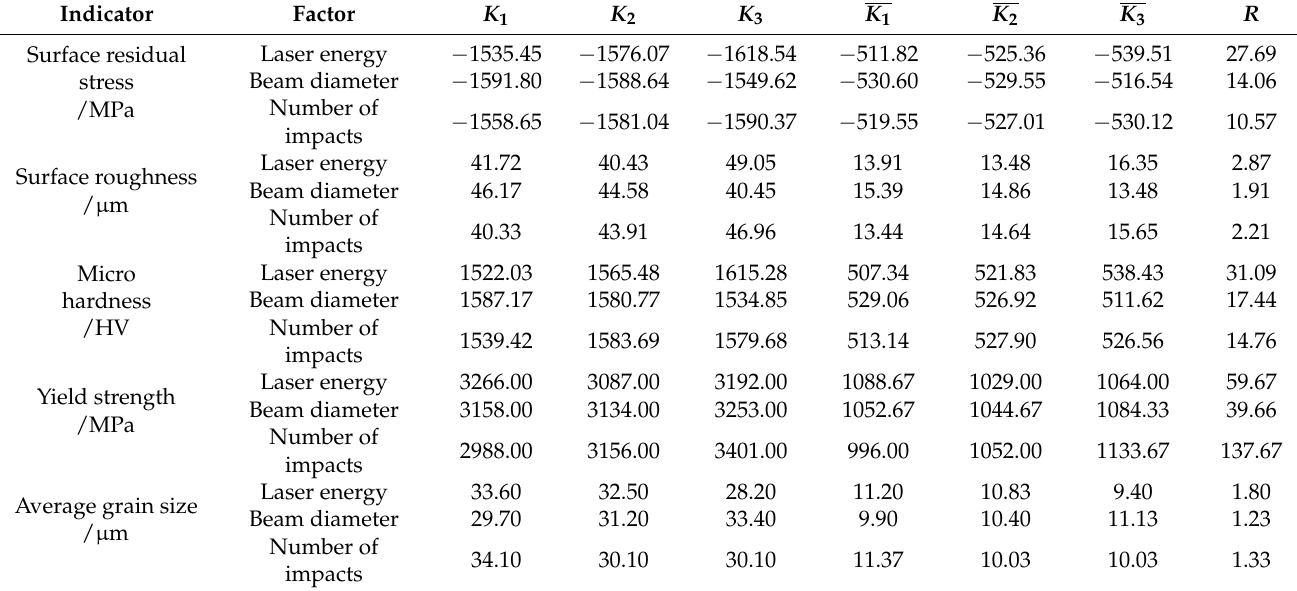
Table 6. Range analysis of different